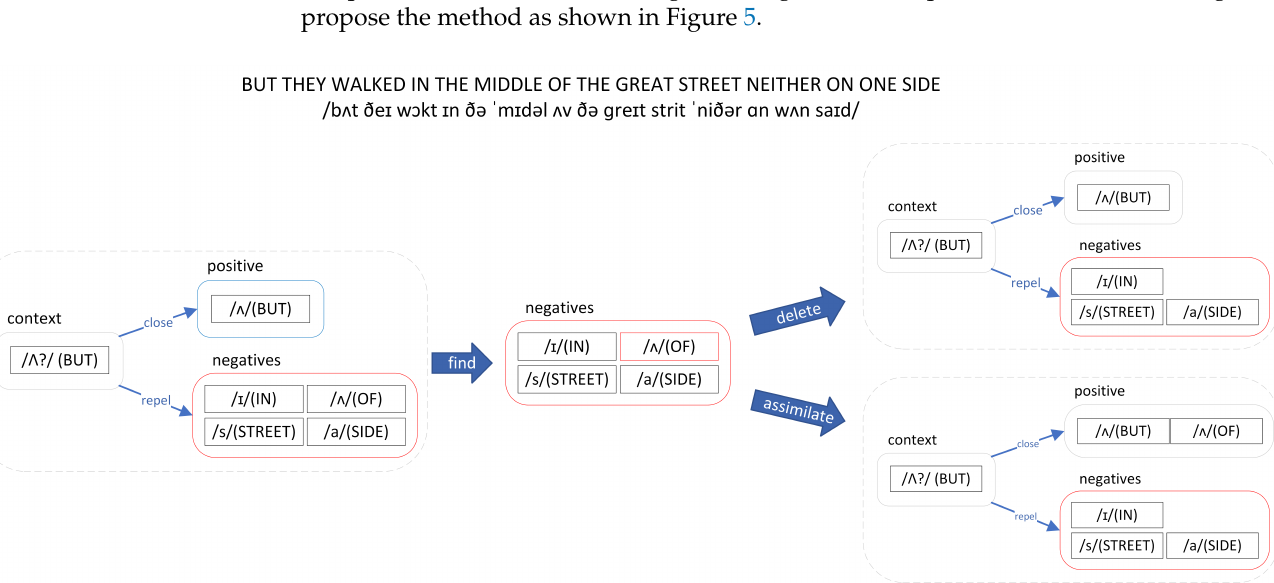
Figure 5. Overview of the proposed method. On the left is the original sample selection, in the middle is the discovery of false negative samples, and on the right are the two strategies of